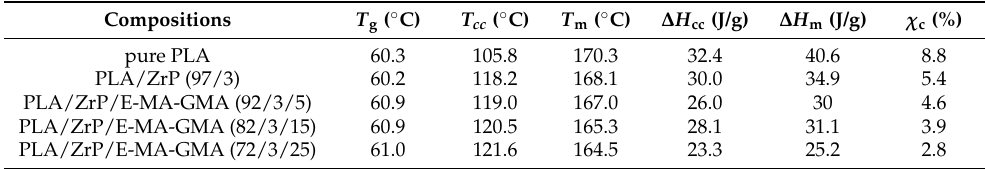
Table 2. The T g , T cc , T m , Δ H cc , Δ H m , and χ c of PLA, PLA/ZrP and PLA/ZrP/E − MA − GMA nanocom- posites.